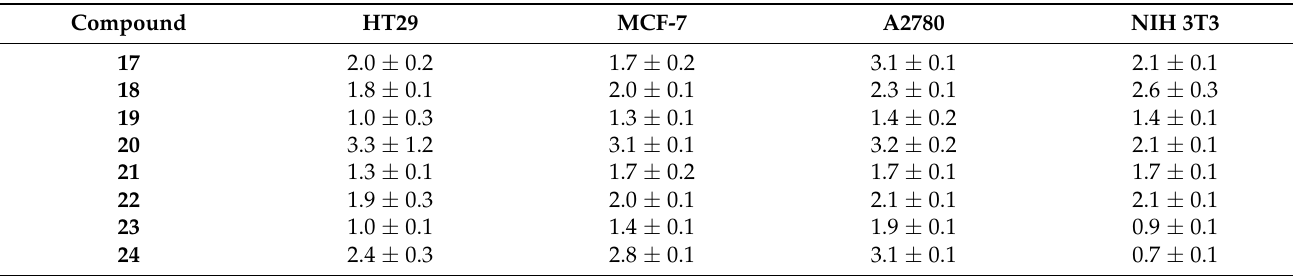
Table 2. (EC 50 in µ M from SRB) of ethylenediamine amides 17 – 20 and piperazine derived amides 21 – 24 . The values are averaged from three independent experiments performed each in triplicate, confidence interval CI = 95%; mean ± standard mean error).